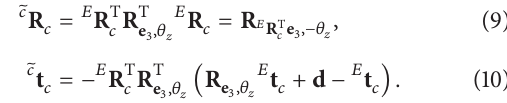
Property 2. The corresponding rotation angle 𝜃 𝑐 of the rota- tion matrix R decomposed from the onboard homography H 𝑠 is of the same size but opposite direction of the rotation angle 𝜃 𝐸 of the robot. In addition, the corresponding rotation axis k mutually